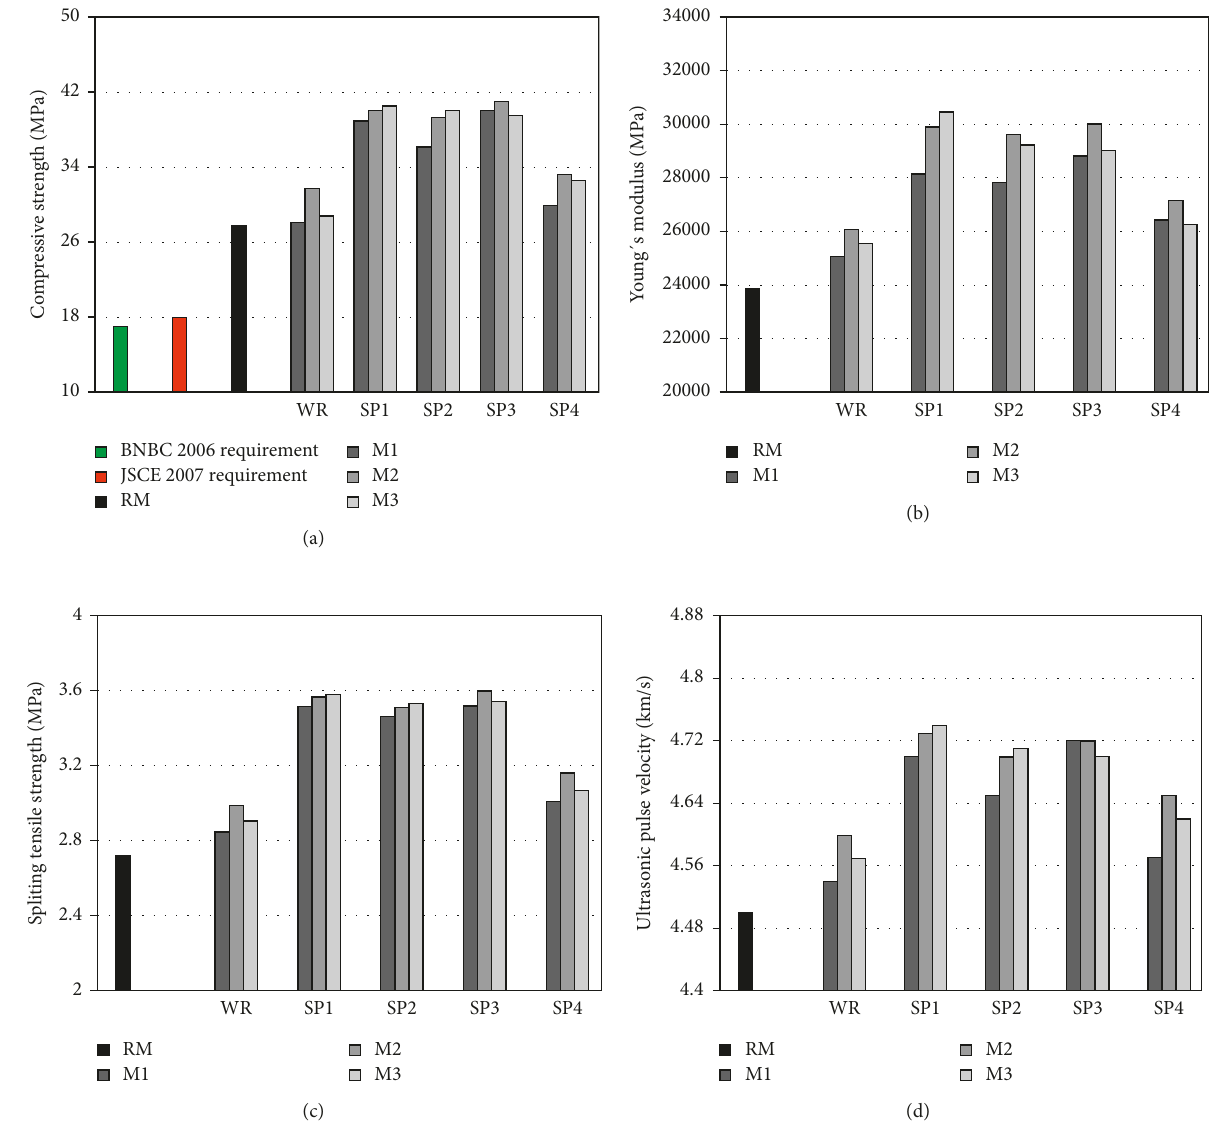
Figure 4: Hardened properties of RM, M1, M2, and M3 concretes (W/C (cid:136) 0.40, s/a (cid:136) 0.40, and C (cid:136) 340 kg/m 3 ) at the age of 28 days: (a) compressive strength, (b) Young’s modulus, (c) splitting tensile strength, and (d) ultrasonic pulse